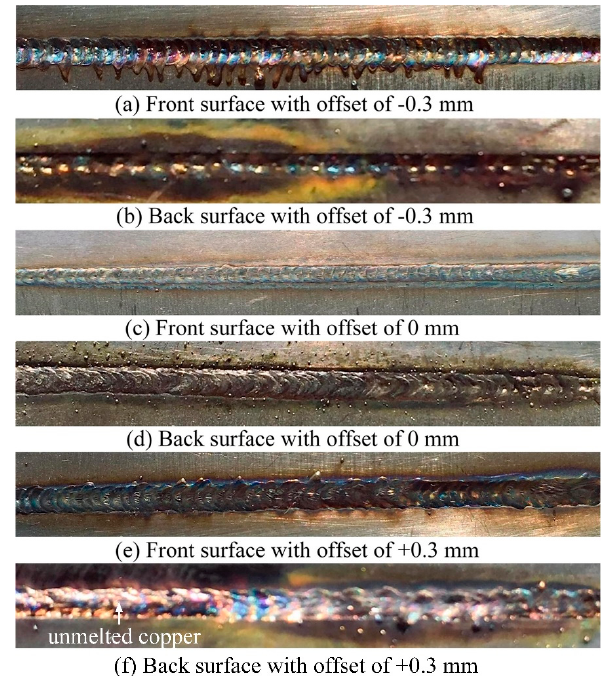
Figure 13. Surface morphologies of 301L/Cu/TA2 welded joints under different offsets: ( a , c , e ) front surface with offset of − 0.3 mm, 0 mm and +0.3 mm, respectively; ( b , d , f ) back surface with offset of − 0.3 mm, 0 mm and +0.3 mm, respectively.